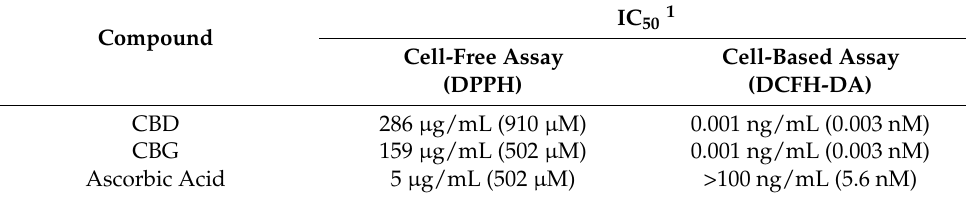
Table 1. Summary of antioxidant activity.